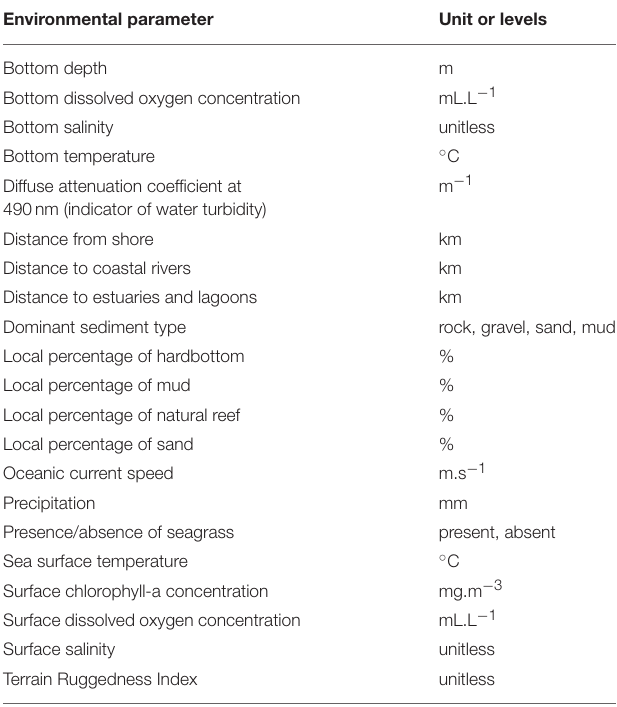
TABLE 3 | Environmental parameters included in the large environmental database for the Gulf of Mexico Large Marine Ecosystem. Environmental